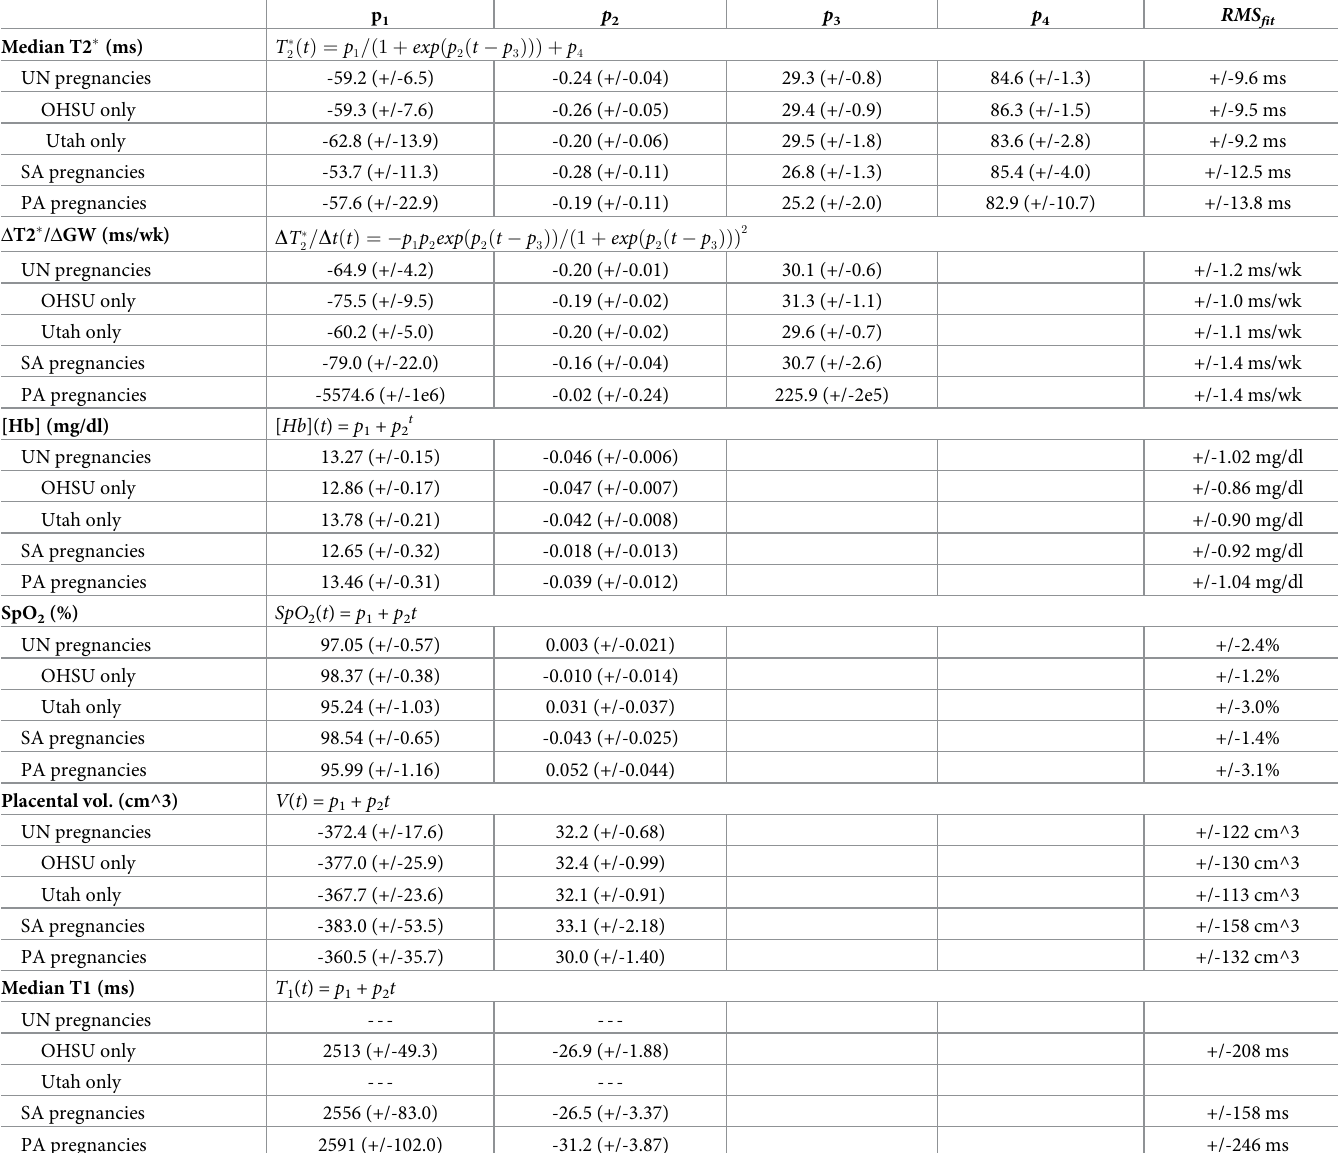
Table 4. Regression models, best fit parameter values and estimated parameter uncertainties, and root-mean-square (RMS) fit residual values for model fits of ges- tational trends in T2 � , Δ T2 � / Δ GW, maternal hemoglobin, maternal blood oxygen saturation, in vivo placental volume, and T1. Fits are presented for the aggregate UN data set along with separate regressions to the OHSU and UU UN subpopulations for normal pregnancies, and for PA and SA